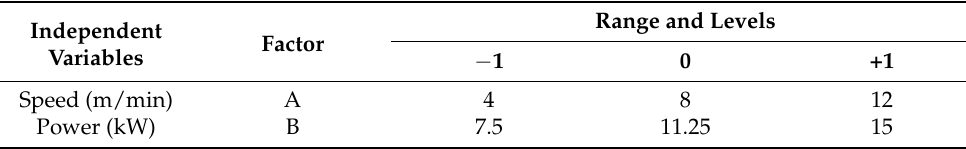
Table 1. Coded and actual levels for the design of the experiment’s